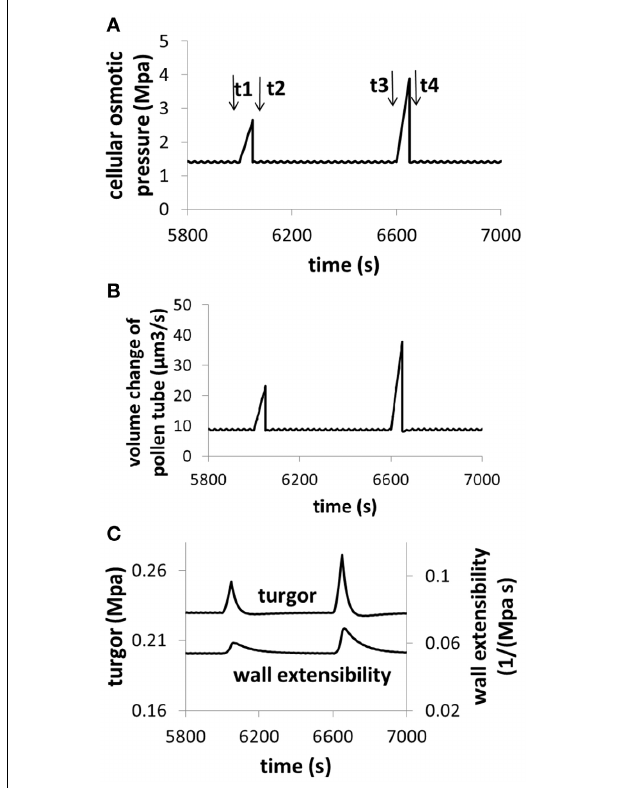
FIGURE 8 | Dependence of volume change, turgor, and cell wall extensibility on cellular osmotic pressure. Osmolarity in the media is 0.36 Osm. (A) An example for increasing cellular osmolarity (e.g., by injection of oil). Before time t1, the cellular osmolarity is 0.5M. From t1 to t2, cellular osmolarity linearly increases from 0.5 to 0.75M due to injection of oil. At time t2, the cellular osmolarity is reset to be 0.5M. From t3 to t4, cellular osmolarity linearly increases from 0.5 to 1.0M due to injection of oil. At time t4, the cellular osmolarity is reset to be 0.5M. (B) Dependence of volume change on cellular osmotic pressure. (C) Dependence of turgor and cell wall extensibility on cellular osmotic pressure. The modeling result of turgor response following the increase of cellular osmotic pressure (8c) is qualitatively in agreement with experimental observations in which cellular osmotic pressure is increased by injection of oil (Benkert et al.,